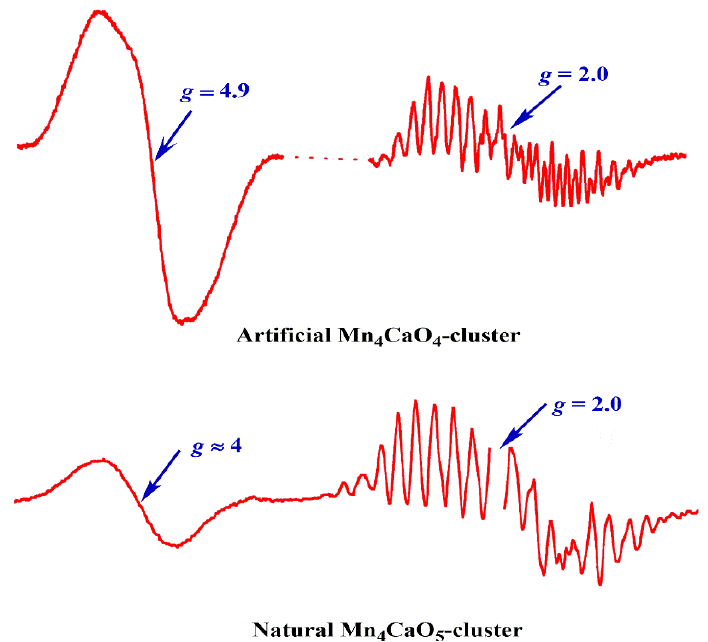
Figure 11. Electron paramagnetic resonance (EPR) spectra for the artificial Mn 4 CaO 4 -cluster [118] (top) and natural Mn 4 CaO 5 -cluster [16] (below) in the S 2 state.